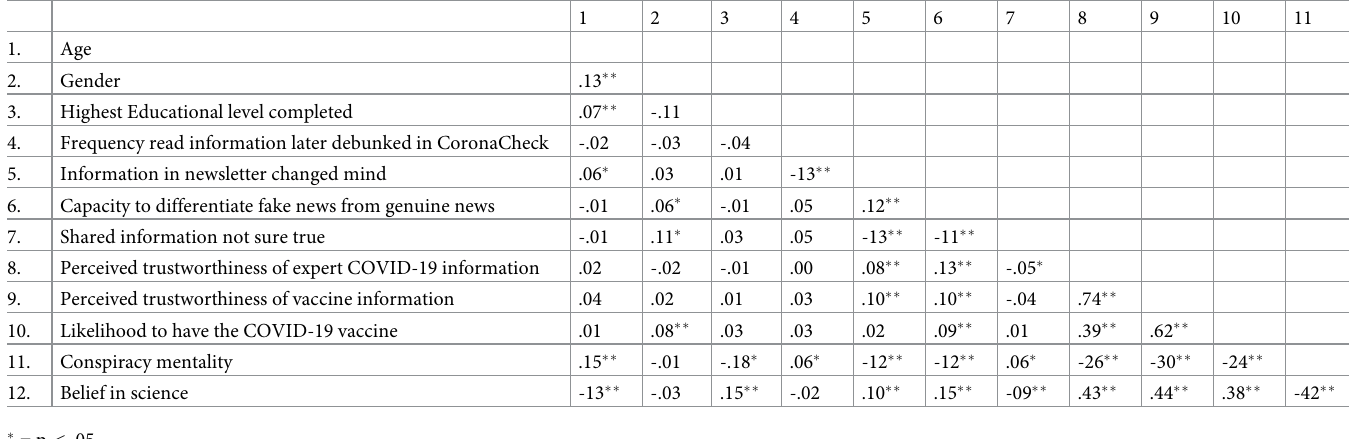
Table 5. Point-Biserial correlations between study